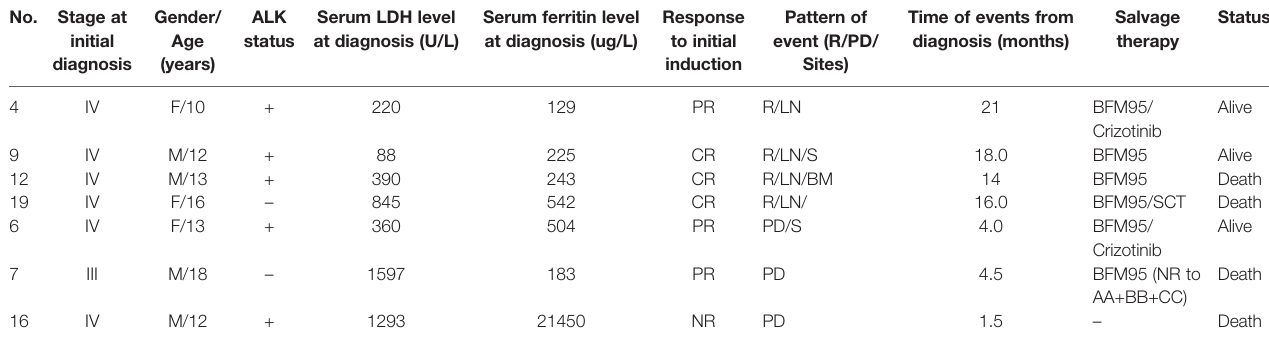
TABLE 2 | Characteristics and outcomes of the patients with relapsed or refractory ALCL. No. Stage at initial